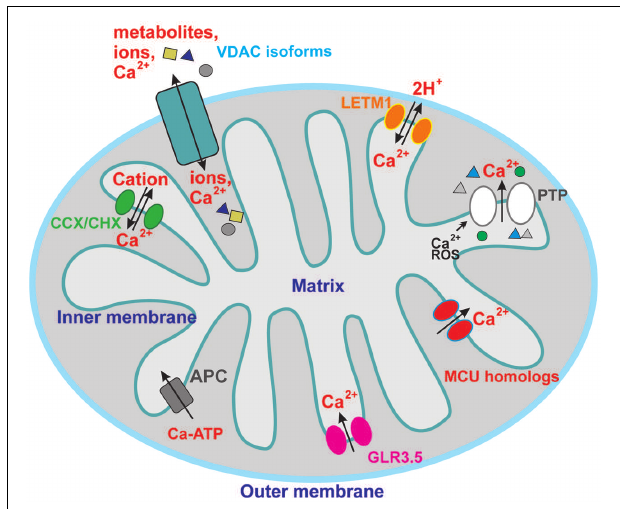
FIGURE 1 | Overview of the putative calcium-permeable ion channels and transporters in plant mitochondria. For sake of clarity, only channels and transporters putatively involved in calcium transport are shown, so the channels mediating flux of other ions are not depicted here. See text for further